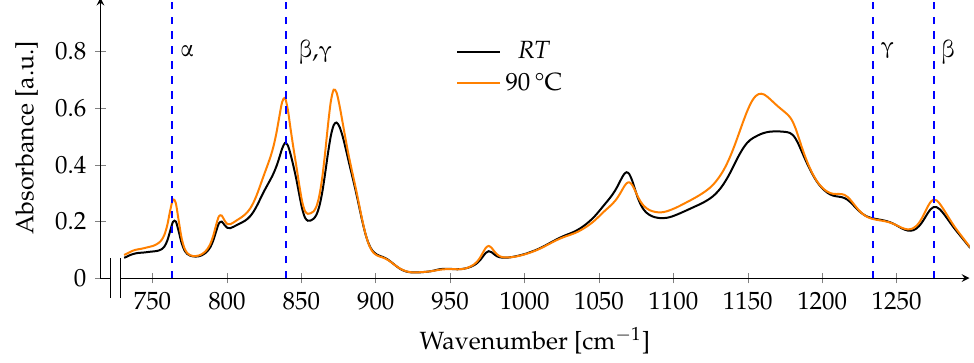
Figure 3. FTIR spectrum before and after annealing at 90°C. Dashed blue lines indicate the main absorption bands of the respective phases at A 763 , A 840 , A 1234 and A 1275 . After annealing at 130 °C, the fraction of F β was calculated to be the lowest of all films with 62%. Nearly all peaks show a decrease in absorbance, the only exception to this is the peak referring to the α -phase at 763 cm − 1 (Figure 4).